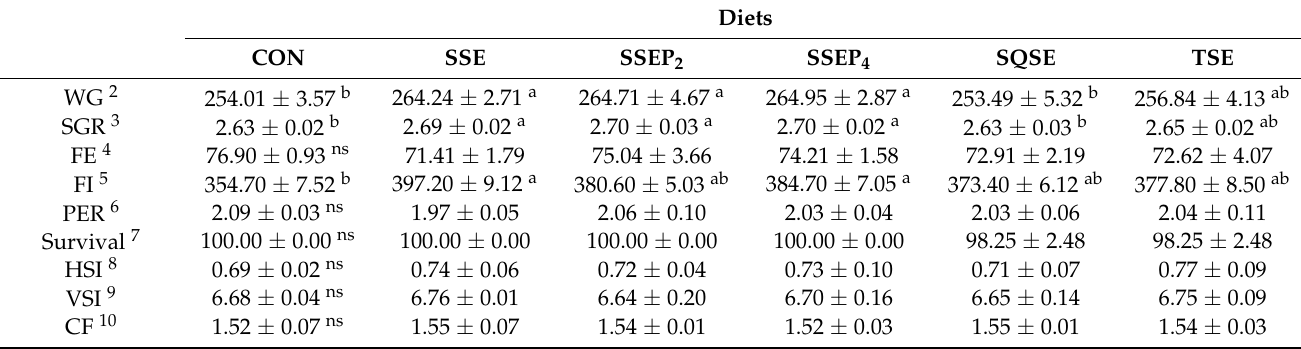
Table 2. Growth performances of juvenile Nile tilapia fed six experimental diets for eight weeks 1 .